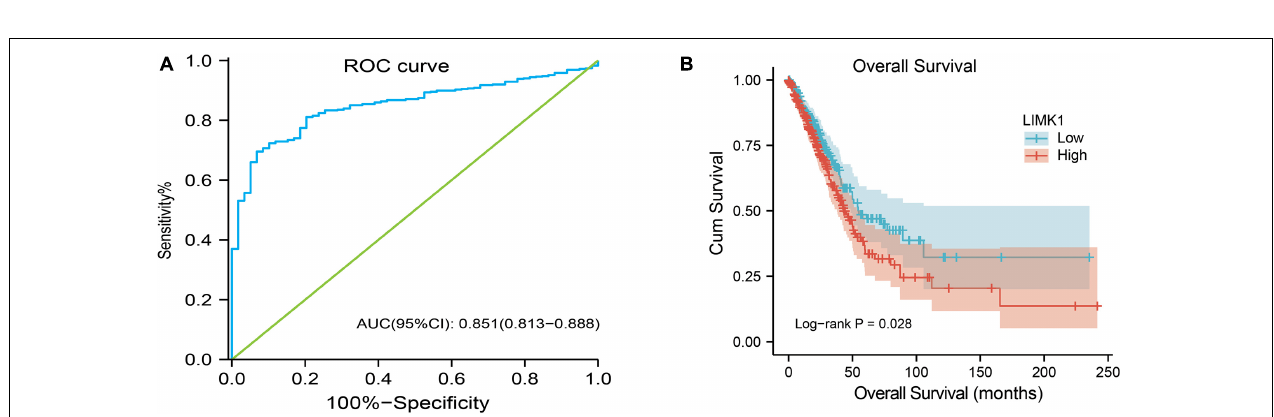
FIGURE 4 | ROC and Kaplan-Meier curves for LIMK1 . (A) ROC curve showed that LIMK1 had an AUC value of 0.851 to discriminate lung adenocarcinoma tissues from healthy controls. With a cutoff of 4.908, the sensitivity, specificity and accuracy were 93.2, 71.9, and 69.5%, respectively. (B) Kaplan-Meier survival curves indicated that lung adenocarcinoma patients with high LIMK1 mRNA expression had a shorter OS than those with low-level of LIMK1 (43.1 vs. 55.1 months, P = 0.028).